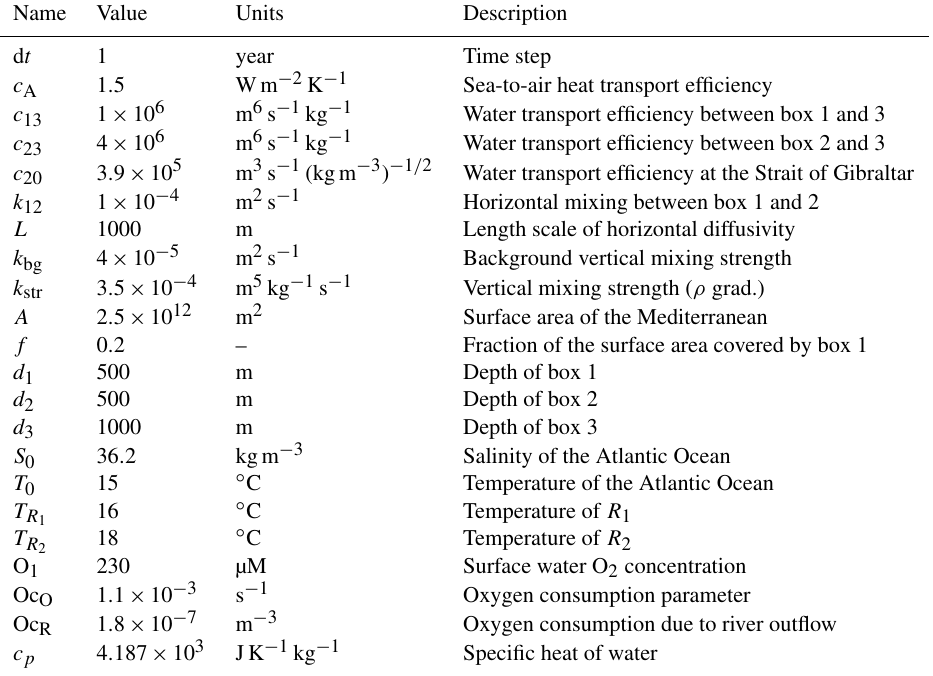
Table 1. All model parameters, excluding the model forcing. Name Value